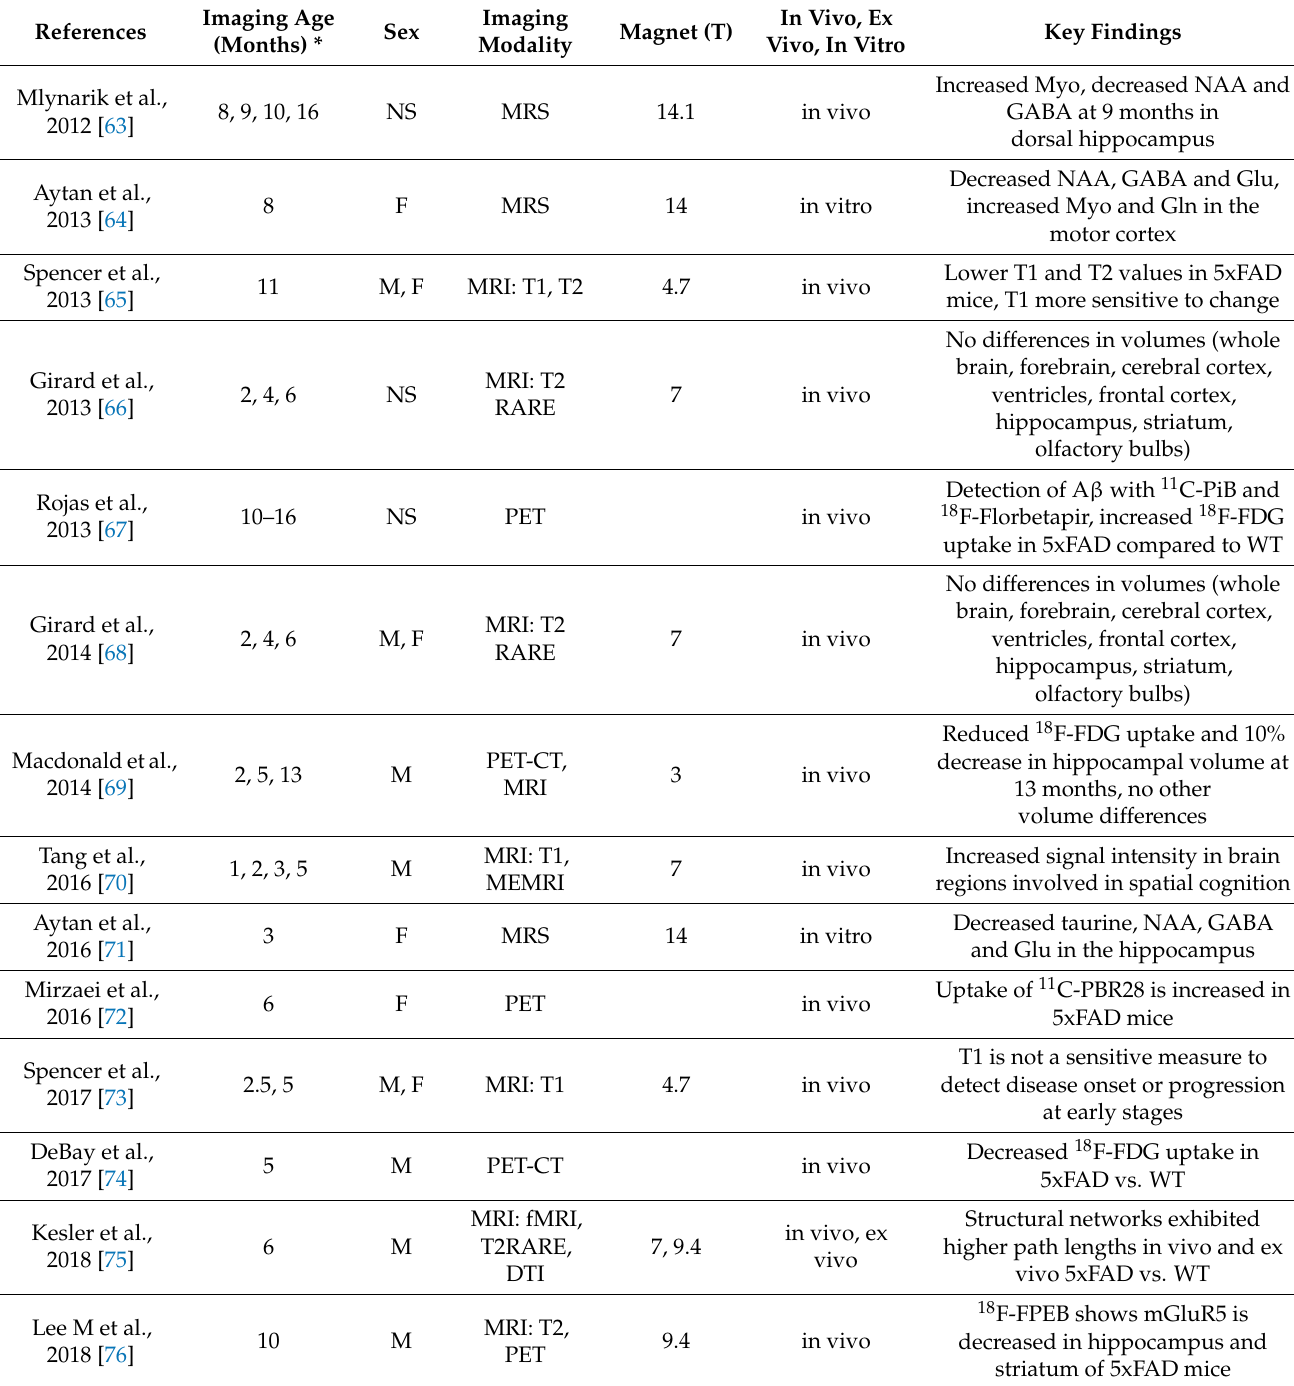
Table 2. Summary of 5xFAD mice